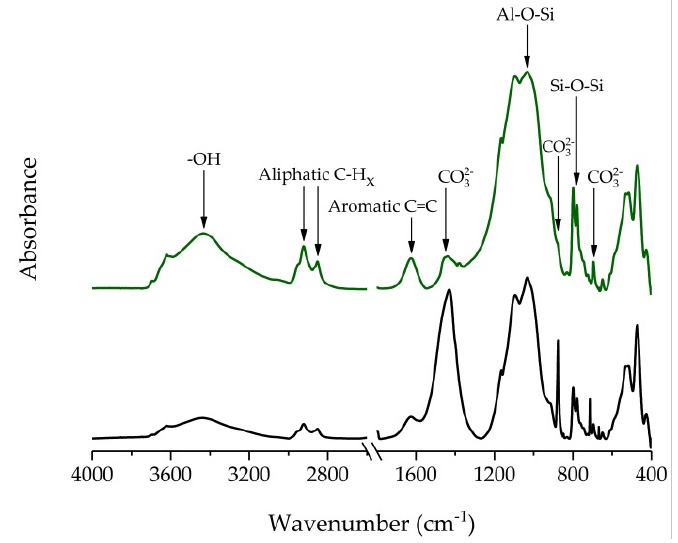
Figure 3. FTIR transmission spectra of the Bazhenov Formation shale rock (sample 1) before (black curve) and after removing carbonate minerals using 36% HCl (green curve).